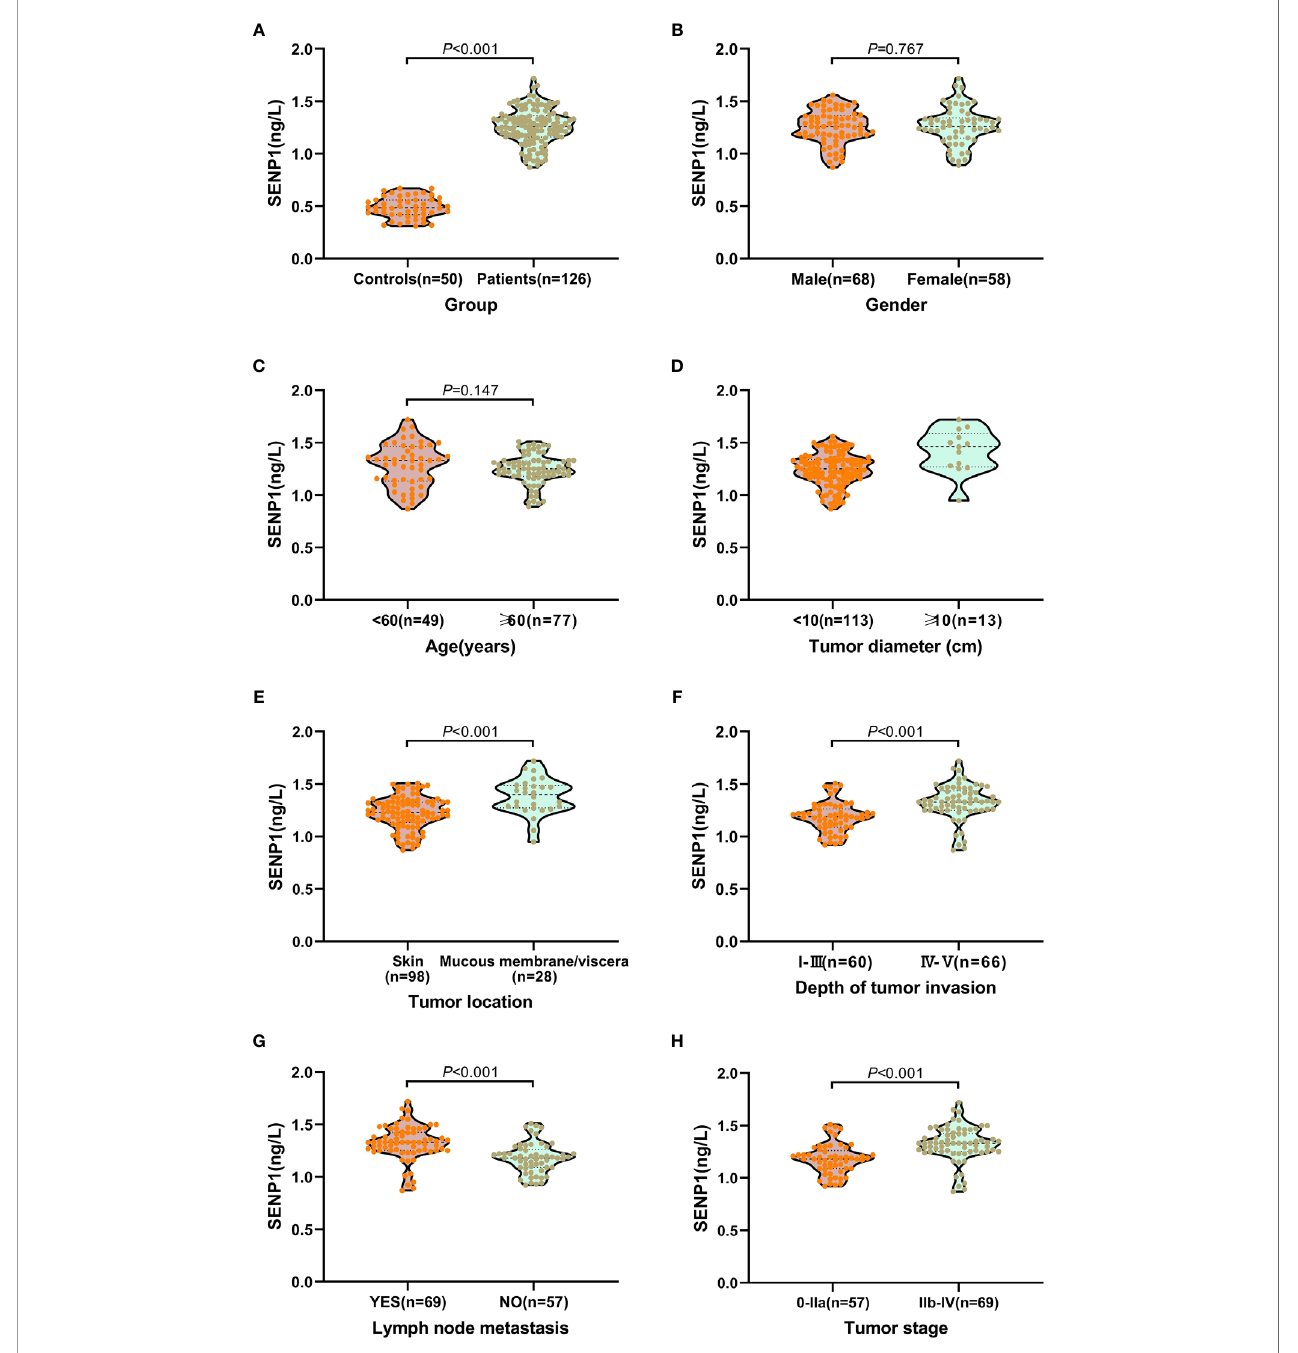
FIGURE 2 | Relationship between plasma exosome-derived SENP1 levels and tumor characteristics. (A) The plasma exosome-derived SENP1 levels in melanoma patients were signi fi cantly up-regulated than in healthy controls ( P < 0.001); (B) No signi fi cant differences were observed between male and female patients ( P = 0.767). (C) No signi fi cant differences were found between patients aged < 60 and >60 years ( P = 0.147). (D) The plasma exosome-derived SENP1 levels in melanoma patients with tumor size more than 10 cm were signi fi cantly higher than in patients in with tumor size less than 10 cm; (E) The plasma exosome-derived SENP1 levels in melanoma patients located in the mucosa or viscera were signi fi cantly higher than in patients located in the skin ( P < 0.001); (F) the plasma exosome-derived SENP1 levels in melanoma patients with Clark level IV - V were signi fi cantly higher than in patients with Clark level I – III ( P < 0.001); (G) the plasma exosome-derived SENP1 levels in melanoma patients with lymph node metastasis were signi fi cantly higher than in patients without lymph node metastasis ( P < 0.001); (H) the plasma exosome- derived SENP1 levels in melanoma patients with TNM stages IIb-IV were signi fi cantly higher than in patients with TNM stages IIb-IV ( P <